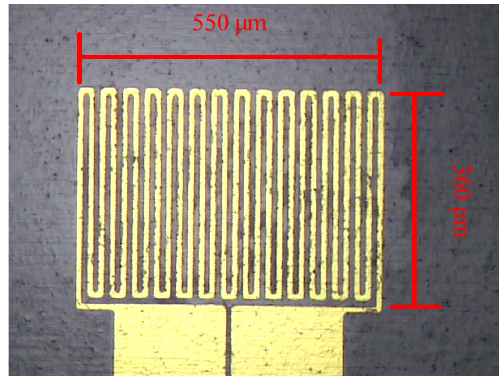
Figure 3. Optical microscopy image of a micro temperature